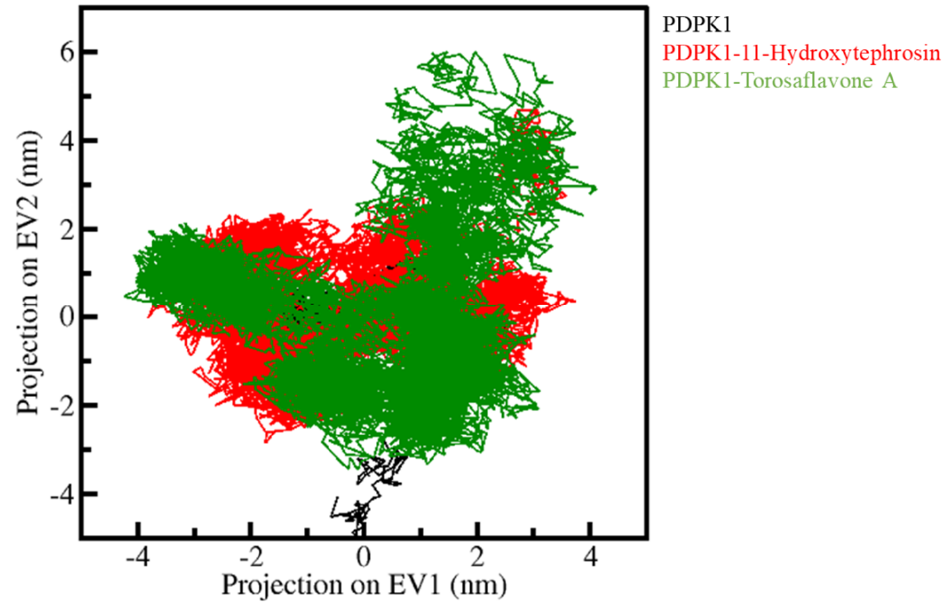
Figure 7. PCA. The 2D-projection of PDPK1, PDPK1-11-Hydroxytephrosin, and PDPK1-Torosaflavone A.